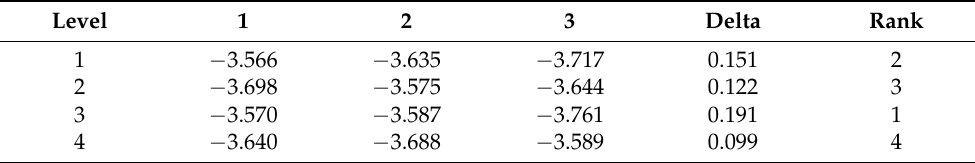
Table 7. Average responses of S/N ratio and